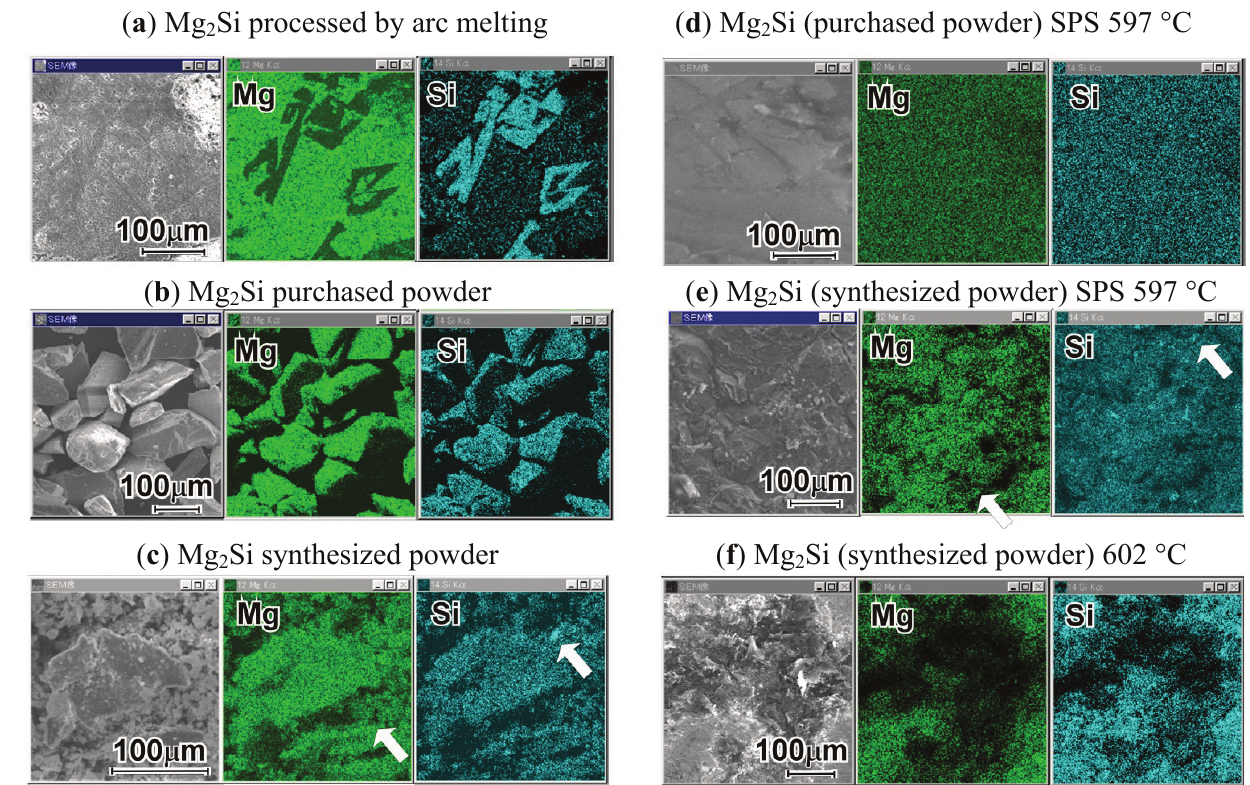
Figure 3. SEM-EDX characterization of the ( a ) arc melted specimen; ( b ) purchased powder; ( c ) synthesized powder ( d ) Spark plasma sintering (SPS) specimen from purchased powder sintered at 597 °C; ( e ) SPS specimen from synthesized powder sintered at 597 °C; ( f ) SPS specimen from synthesized powder sintered at 602